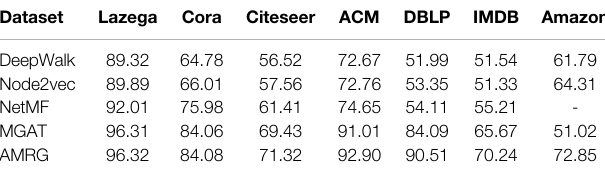
TABLE 5 | Node classi fi cation F1-score ( % ) (bold: